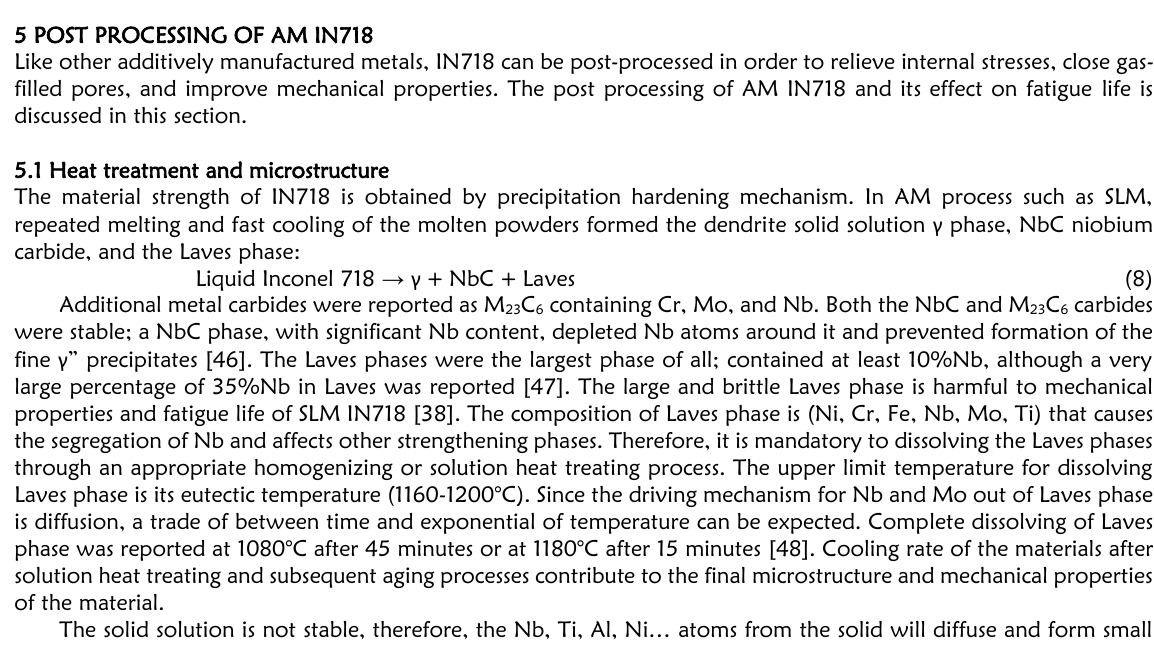
Table 4. Mechanical properties of IN718 bar stock subjected to AMS-5662 standard heat treatment [41,45]. Property Room Temperature 649  C Tensile Strength (MPa) 1240 970 Yield Strength (MPa) 1030 860 % Elongation 10 10 % Area Reduction 12 12 Hardness 331 BHN - 5 POST PROCESSING OF AM